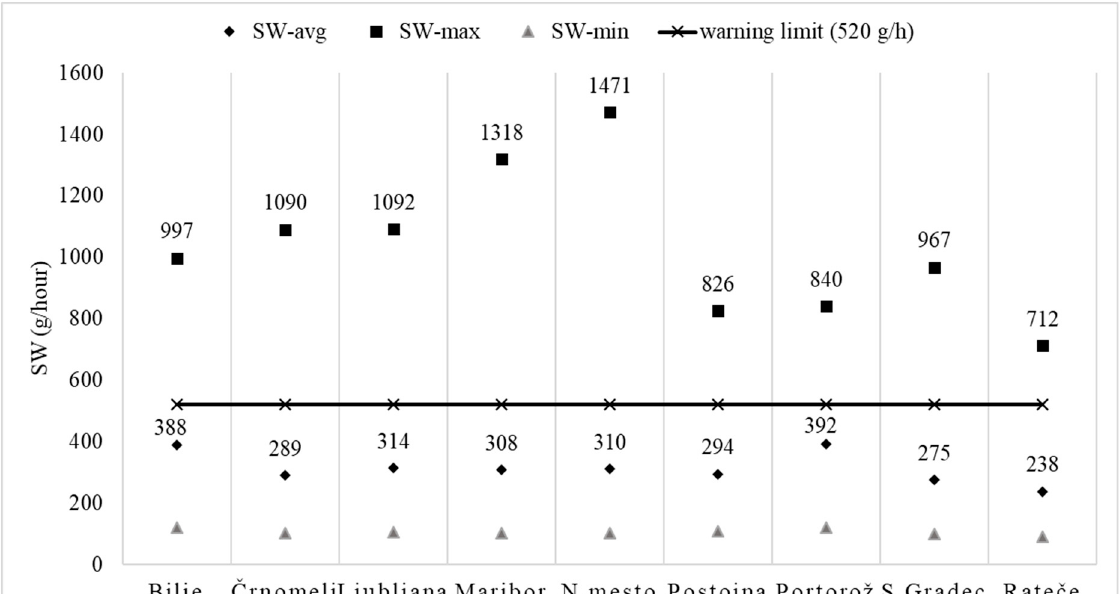
Figure 6. Minimum (min), mean (avg), and maximum (max) summer values of the water loss index (SW) at the studied locations, the line indicates the warning limit for the risk of dehydration. Calculated average MHR for summer days at 14:00 CEST are the lowest in Portorož (115 Wm − 2 ), Bilje (122 Wm − 2 ), and ˇCrnomelj (125 Wm − 2 ), slightly higher in Ljubljana, Novo Mesto (135 Wm − 2 ), and Maribor (139 Wm − 2 ), around 150 Wm − 2 in Postojna and Slovenj Gradec, and the highest value, 170 Wm − 2 , applies to